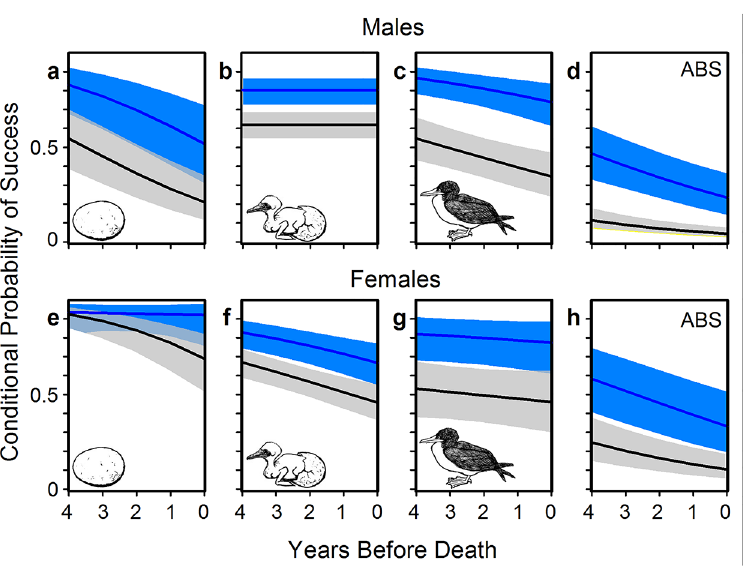
Fig 5. Component stages of Annual Breeding Success of presumed old adults by Fish Phase. Predictions for SardinePhase (blue) and Flying Fish Phase (gray) shown as in Fig 3. Data are derived only from the 12 yrs of the study with detailed histories on the componentsof each breedingattempt. See Methods for years involvedin each stage. Conditional probabilities for different stages are p(initiatea clutch | alive) (panels a, e), p(hatch an egg | clutch was initiated)(panels b, f), p(produceindependentoffspring | hatch) (panels c, g), and p(produceindependent offspring | alive) for only the subset of years for which analysisof componentswas possible(panels d, h). Sample size varies by sex/response variable.Full model results given in S3, S4 and S8 Tables.